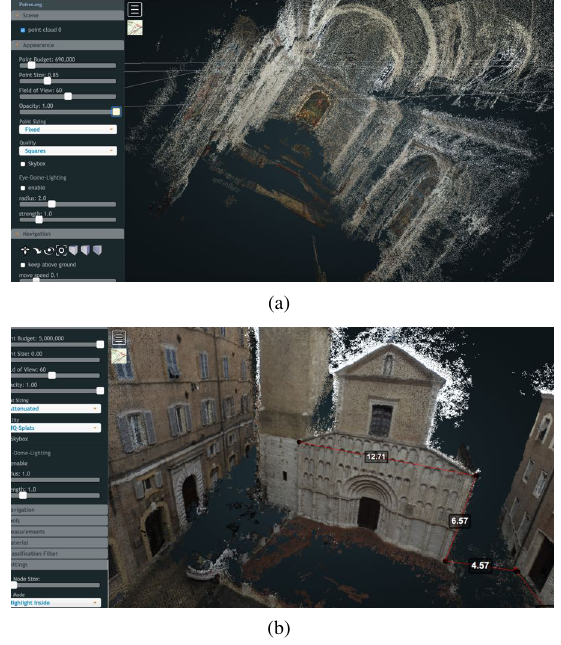
Figure 8. Web visualization of the point clouds. The tool